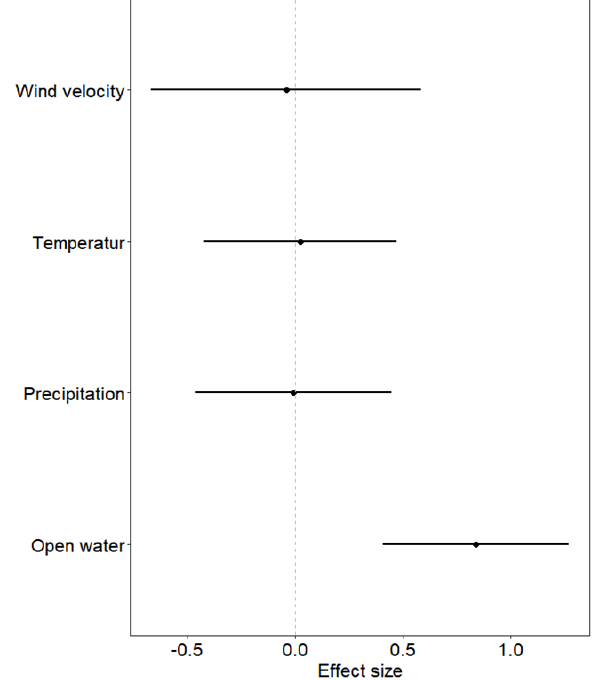
Figure 3. Effect sizes of Precipitation, Temperature, Open water, and Wind velocity on population trend of bar-headed geese. Effect sizes are weighted average standardized coefficients across models with ∆AICc < 6 . The lines represent 95% confidence interval (CI).